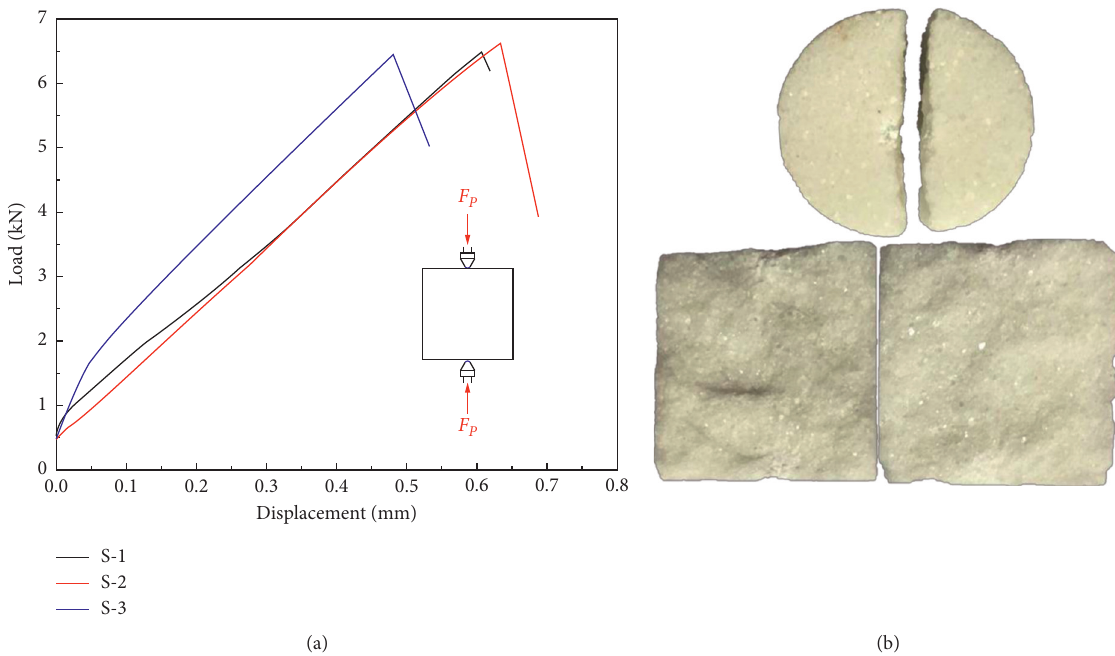
Figure 4: Point load test under static load. (a) Load-displacement curve. (b) Failure mode.